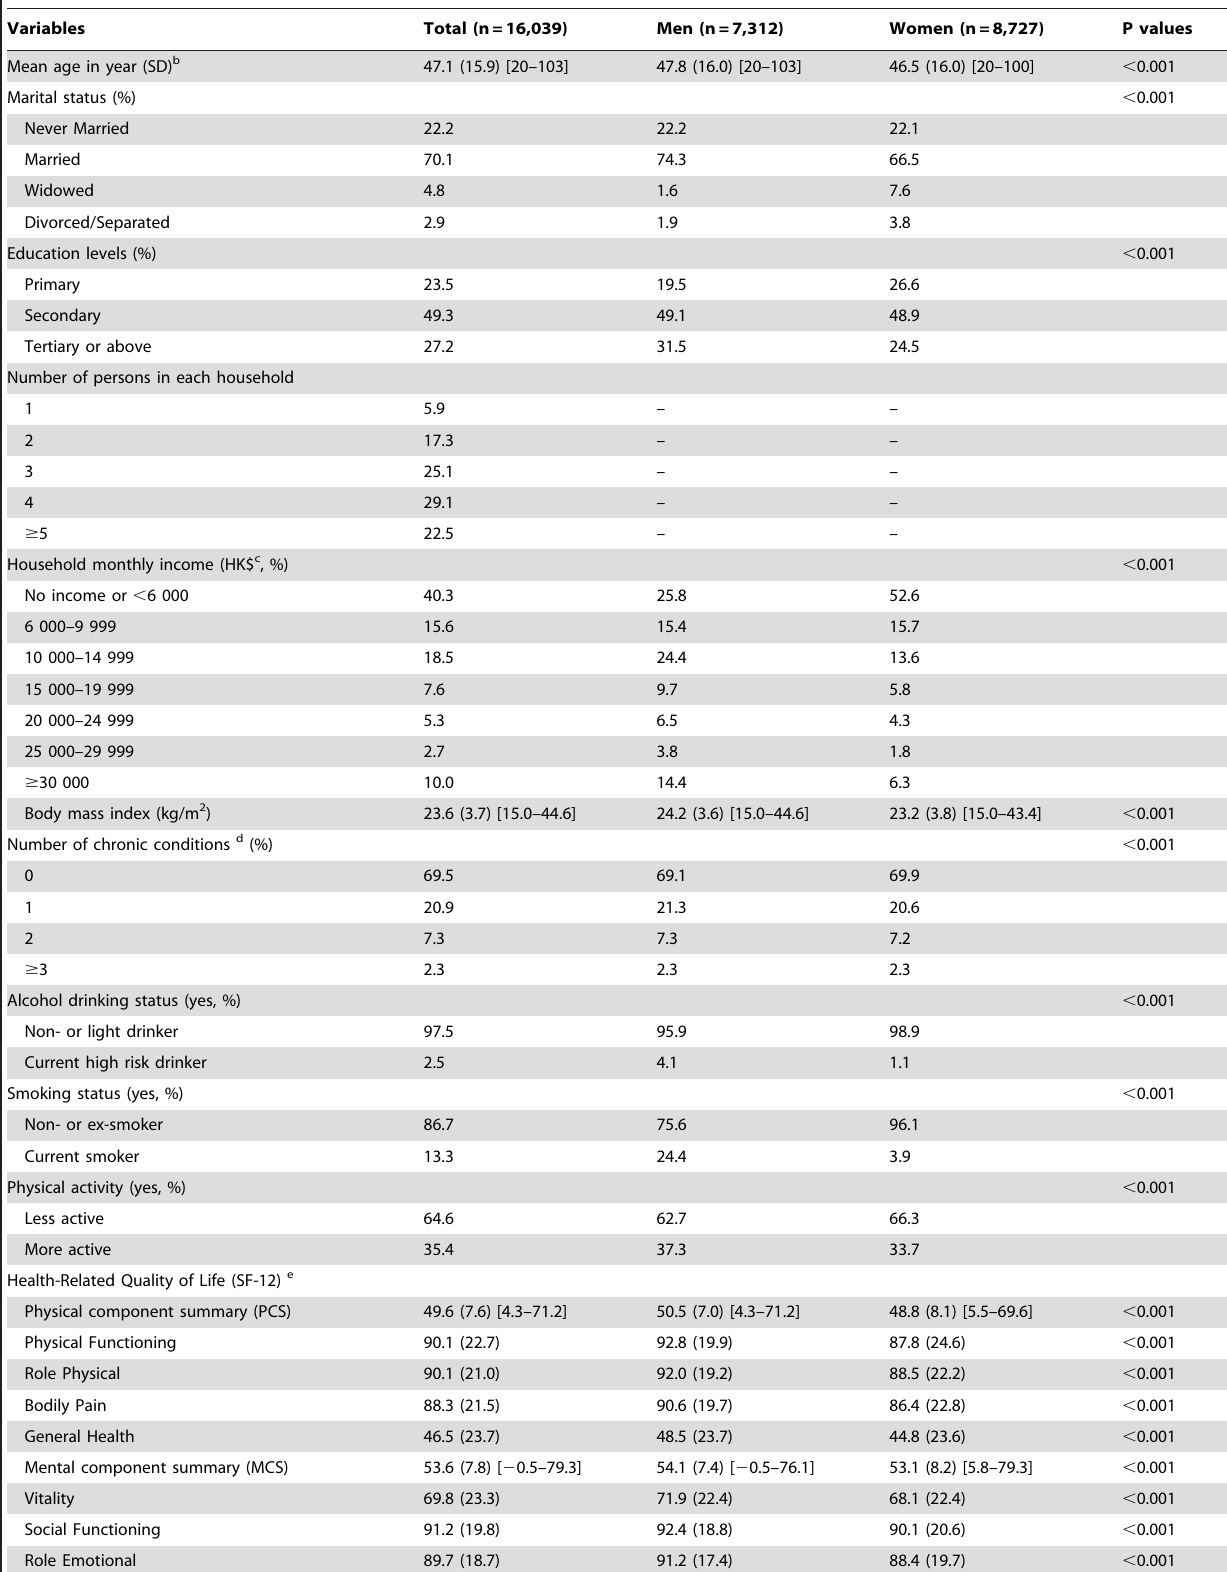
Table 2. Characteristics of the study sample and its difference between men and women.